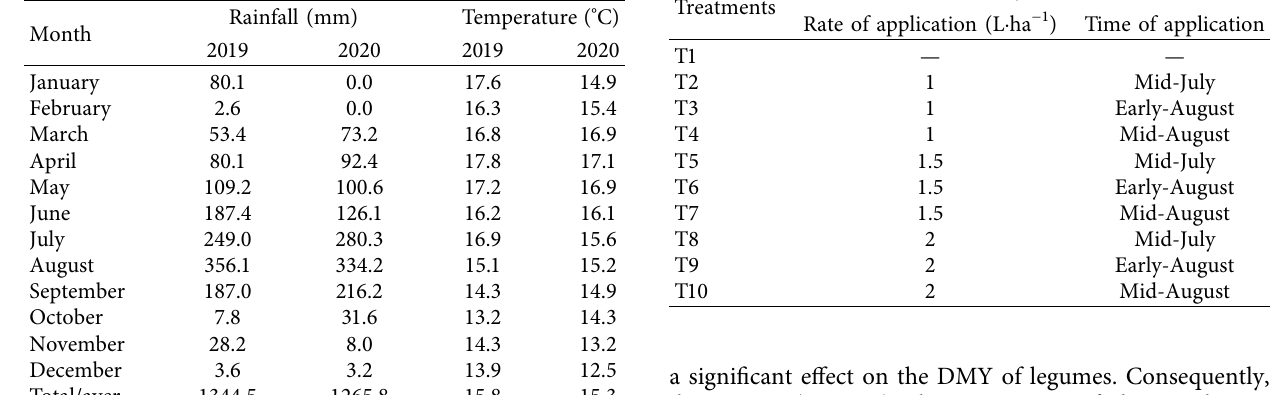
Table 2: Monthly total rainfall and monthly mean temperature of the study area.